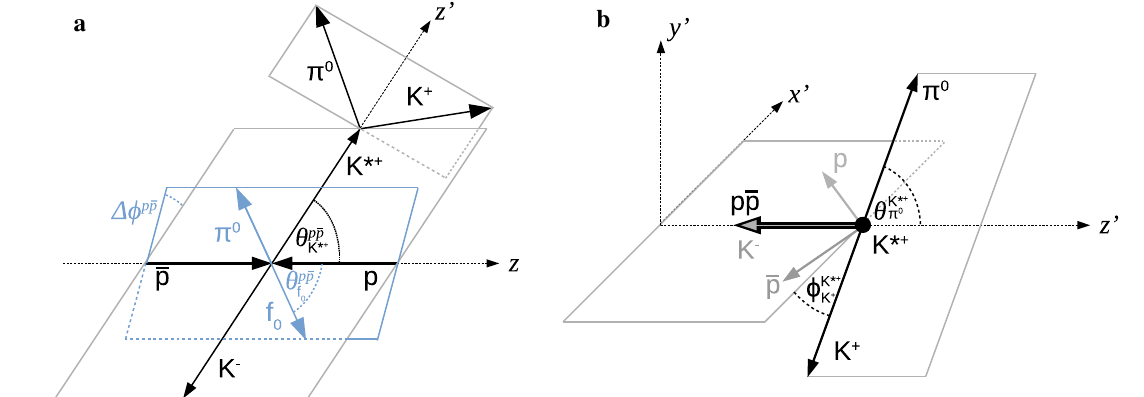
decaying into K + K − (blue). The angle Δφ ¯ pp is the angle between the planesofthesetwodecaybranches.AccordingtoEq.(3) K ∗+ standsfor X . In the helicity frame of the K ∗+ depicted in b , the z (cid:8) axis is defined by the opposite direction of the ¯ pp system or equivalently of the K − particle. The x (cid:8) − z (cid:8) plane is given by the production plane, spanned by the flight directions of the proton and antiproton. Accordingly, the y (cid:8) axis is perpendicular to this production plane. K ∗+ corresponds to X , + to s π 0 to s 1 and K 2 which are given in Eq.